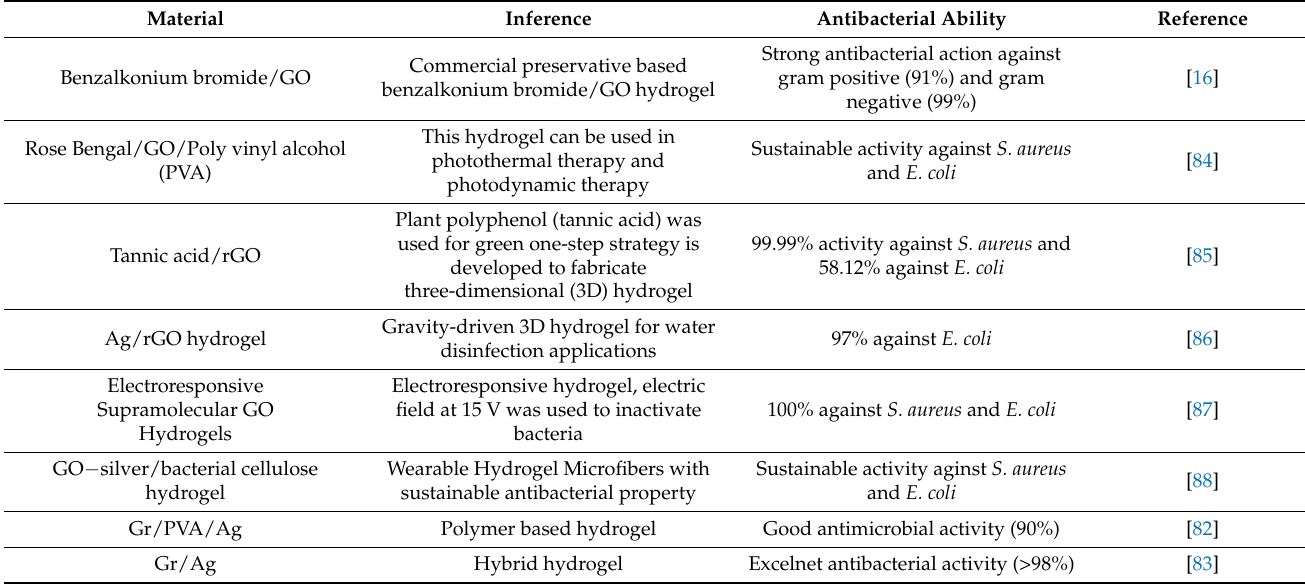
Table 1. Examples of graphene-based